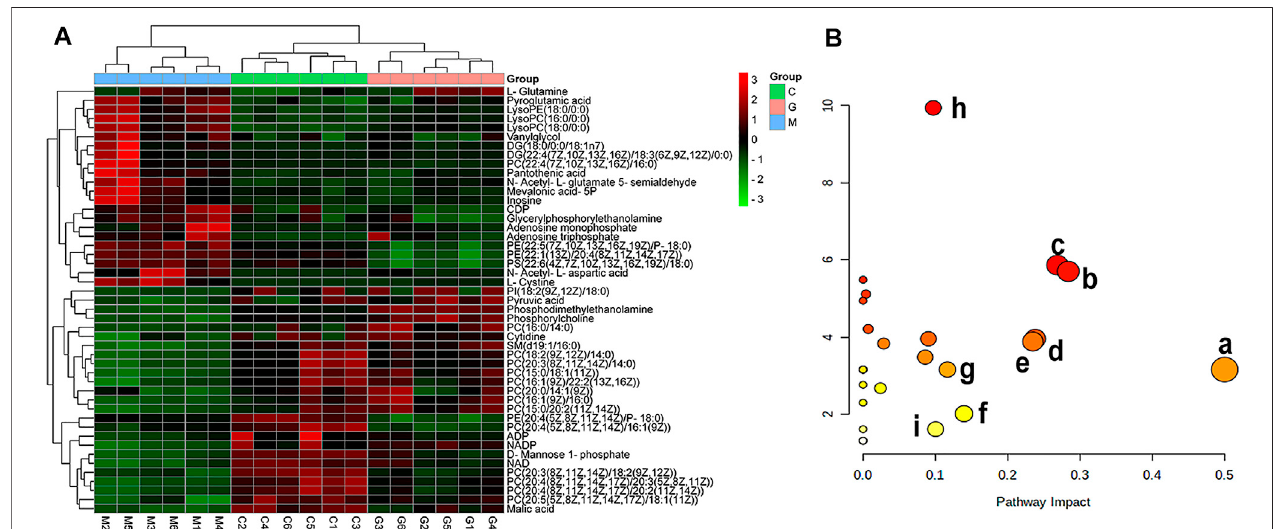
FIGURE 8 | (A) Hierarchical clustering heatmap of 47 potential biomarkers. (Columns represent samples in different groups, and rows represent different biomarkers.Differentcolors,fromgreentoblacktored,representconcentrationdifferences,fromsmalltolarge,indifferentsamples.C,G,andMin fi gurecorrespondto shNC group, GDD group, and shATP7B + Cu, respectively); (B) Results of metabolic pathway analysis of copper-laden HLD hepatocytes [each point represents a metabolic pathway: (a) D-glutamine and D -glutamate metabolism; (b) alanine, aspartate, and glutamate metabolism; (c) glycerophospholipid metabolism; (d) pyruvate metabolism; (e) nicotinate and nicotinamide metabolism; (f) terpenoid backbone biosynthesis; (g) fructose and mannose metabolism; (h) arginine biosynthesis; (i)